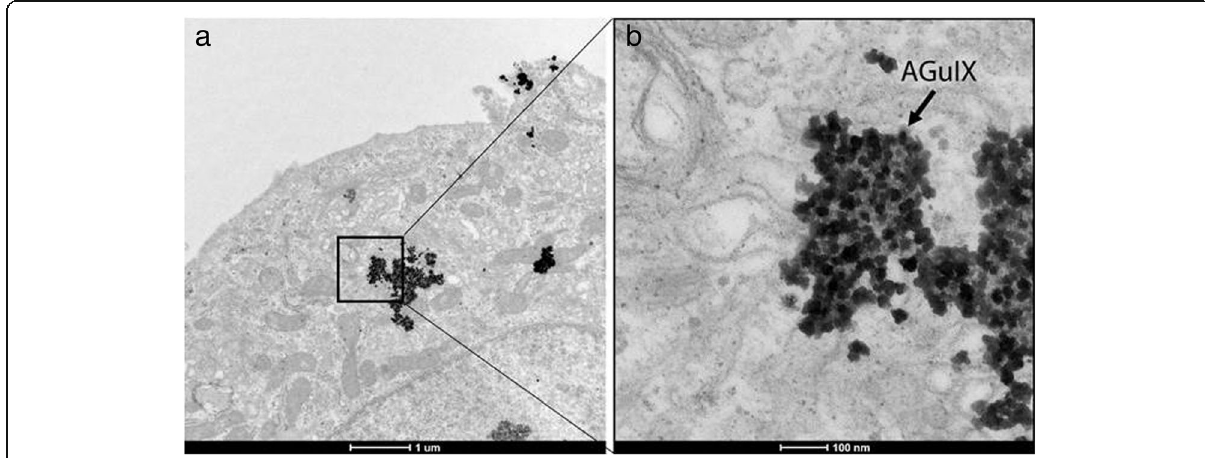
Fig. 1 Localization of AGuIX within HepG2 cells. a . TEM images (× 6500) depict the uptake of AGuIX into the HepG2 cells. b . Magnified TEM image (× 52000) shows the distribution of AGuIX nanoparticles in the